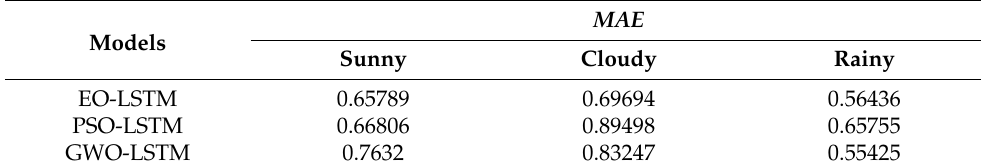
Table 8. MAE of each optimization model under different weather conditions.